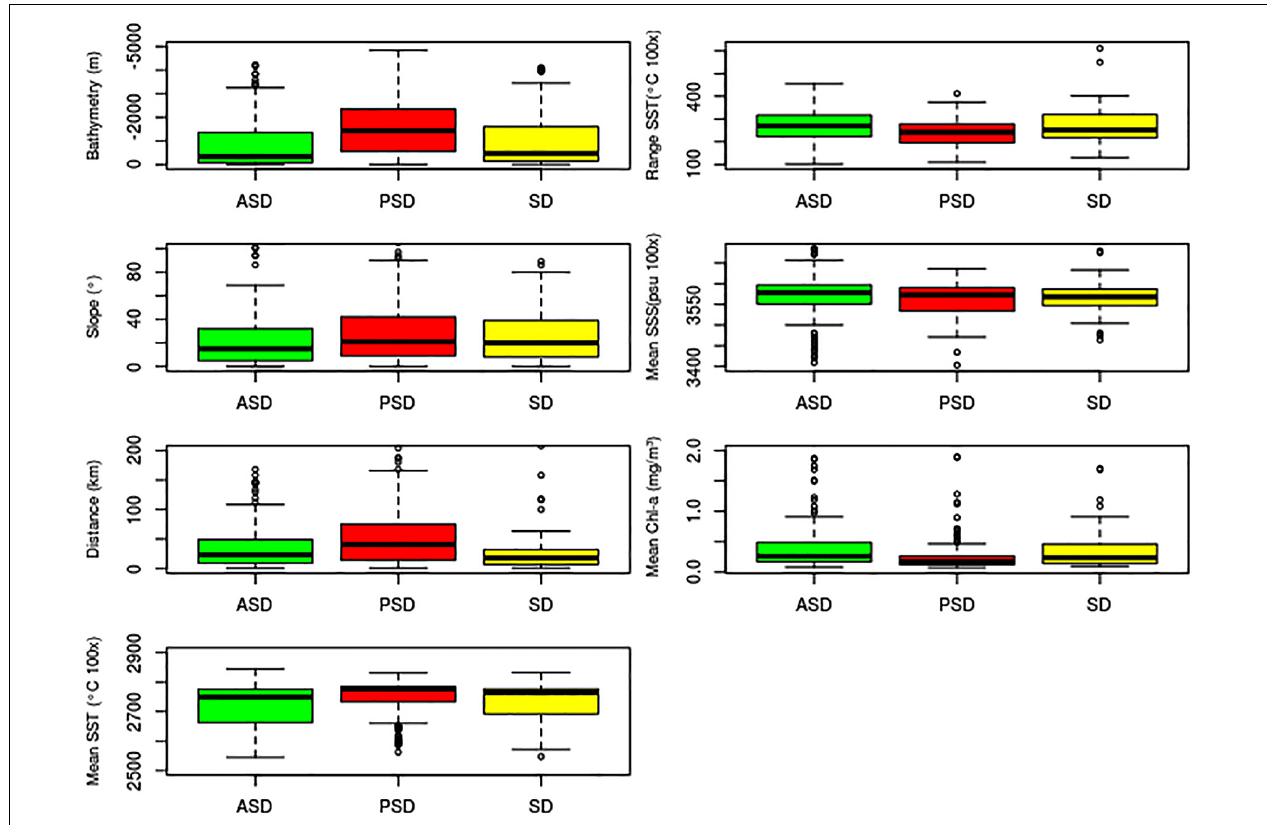
FIGURE 9 | Box plots of values extracted from environmental layers for Atlantic spotted dolphins (ASD), pantropical spotted dolphins (PSD) and spinner dolphins (SD) in the Caribbean Basin. The thick horizontal line inside each box represents the median; the upper and lower borders of the box are the 25th and 75th percentiles; the 5th and 95th percentiles are represented by the error bars; small circles are outliers.